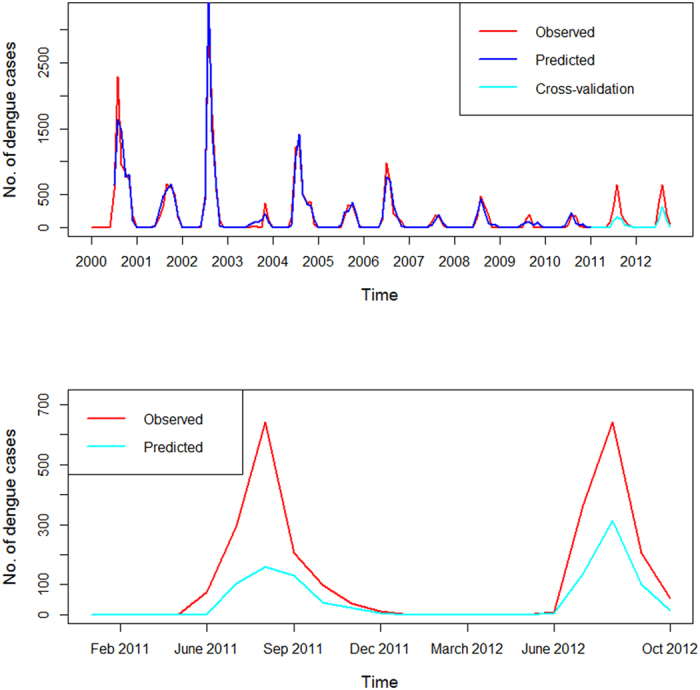
Cross validation of distributed lag nonlinear model.A natural cubic spline with three degrees of freedom was used for both Nino3.4 and DMI to smooth the data.